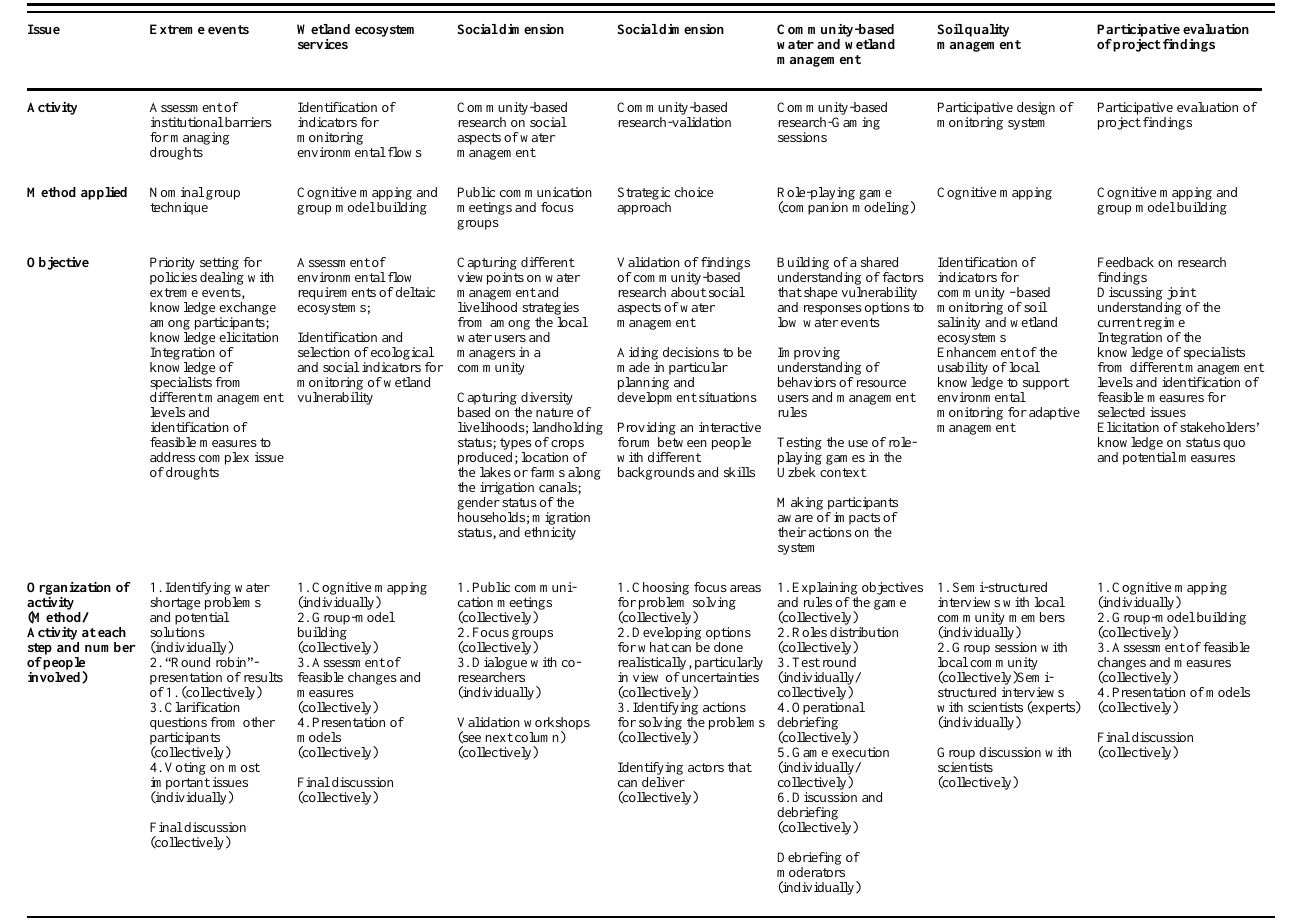
Table 1 . Activities in the Amudarya case study and participative methods